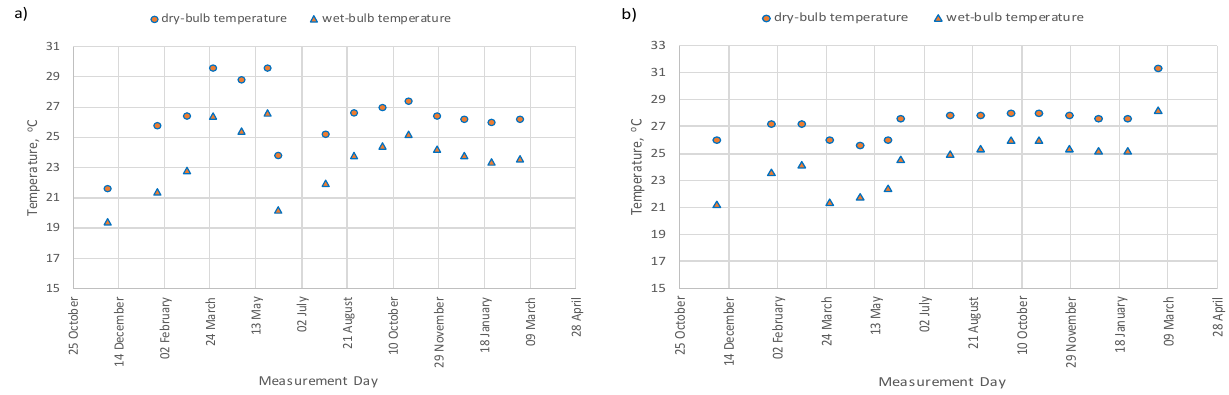
Figure 4. Changes in air temperature in the heading under analysis; ( a ) at the working face, ( b ) entrance of the heading.